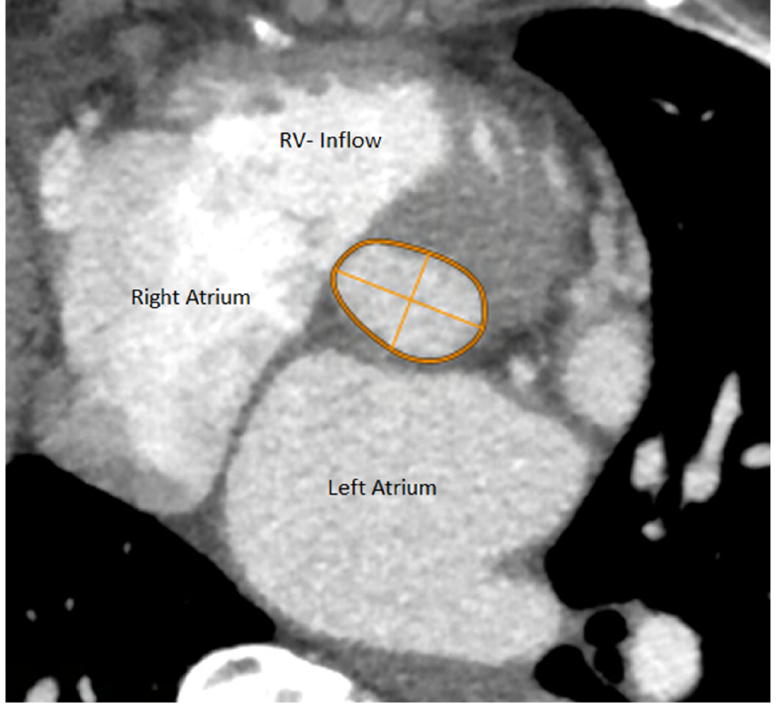
Figure 1. Slice through the heart within the Aortic Annulus plane with parameters measured upon MDCT.